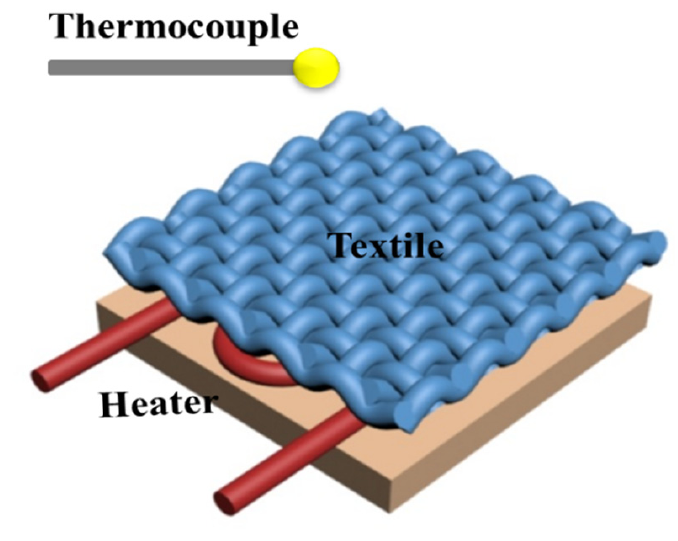
Figure 1. Schematic diagram of thermal regulation performance test of functional